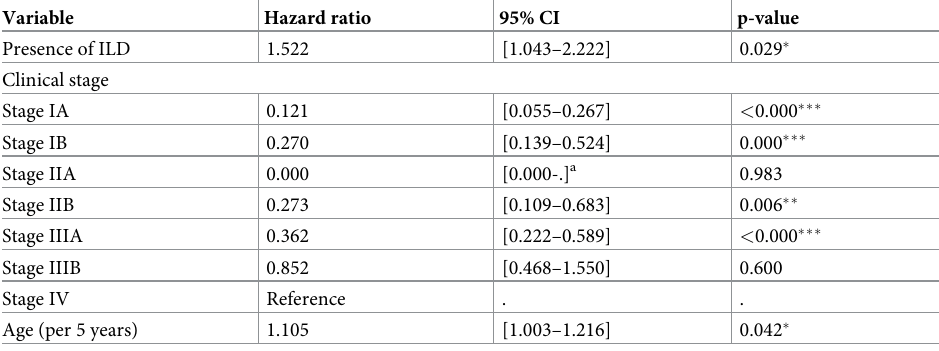
Table 4. Estimated hazard ratio from adjusted cox